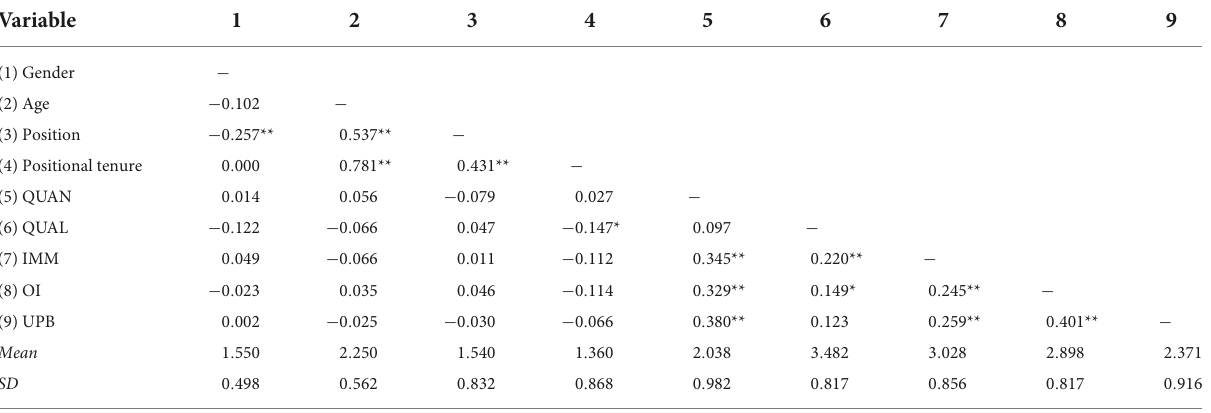
TABLE 1 Variable means, standard deviations (SDs), and correlation coefficients ( N = 254). Variable